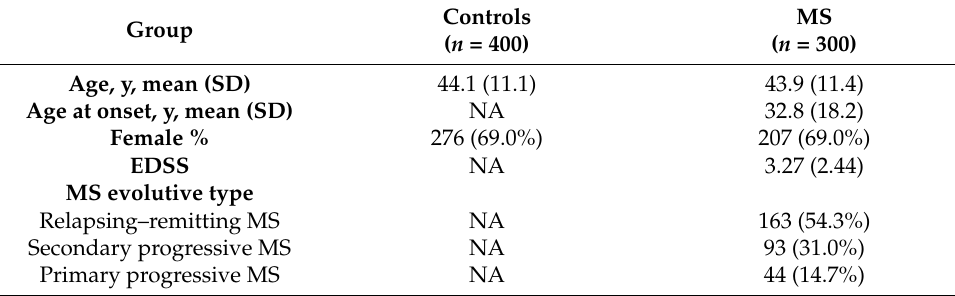
Table 7. Demographic and clinical data of the series